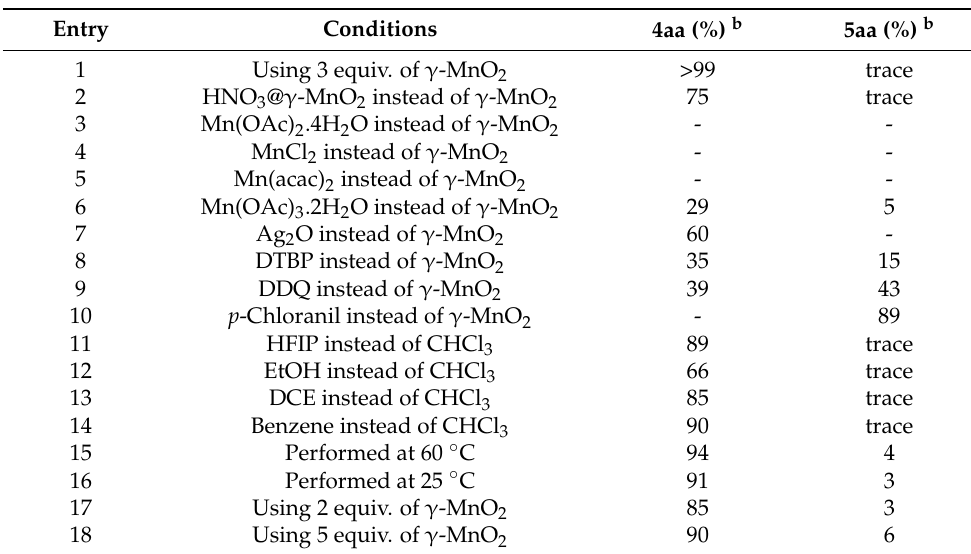
Table 1. Optimization of the reaction conditions 1 .